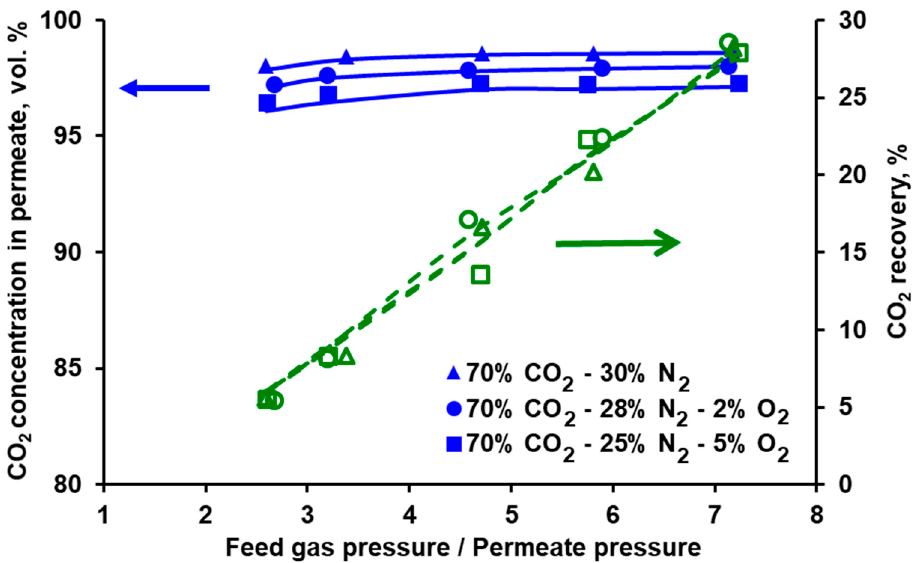
Figure 10. Experimental (points) and theoretical (lines) CO 2 purity and recovery in UBE UMS-A5 module against feed to permeate pressure ratio for various inlet oxygen concentration. Inlet CO 2 concentration: 70 vol.%, temperature: 298 K, feed gas flow rate: 0.05 kmol h − 1 .